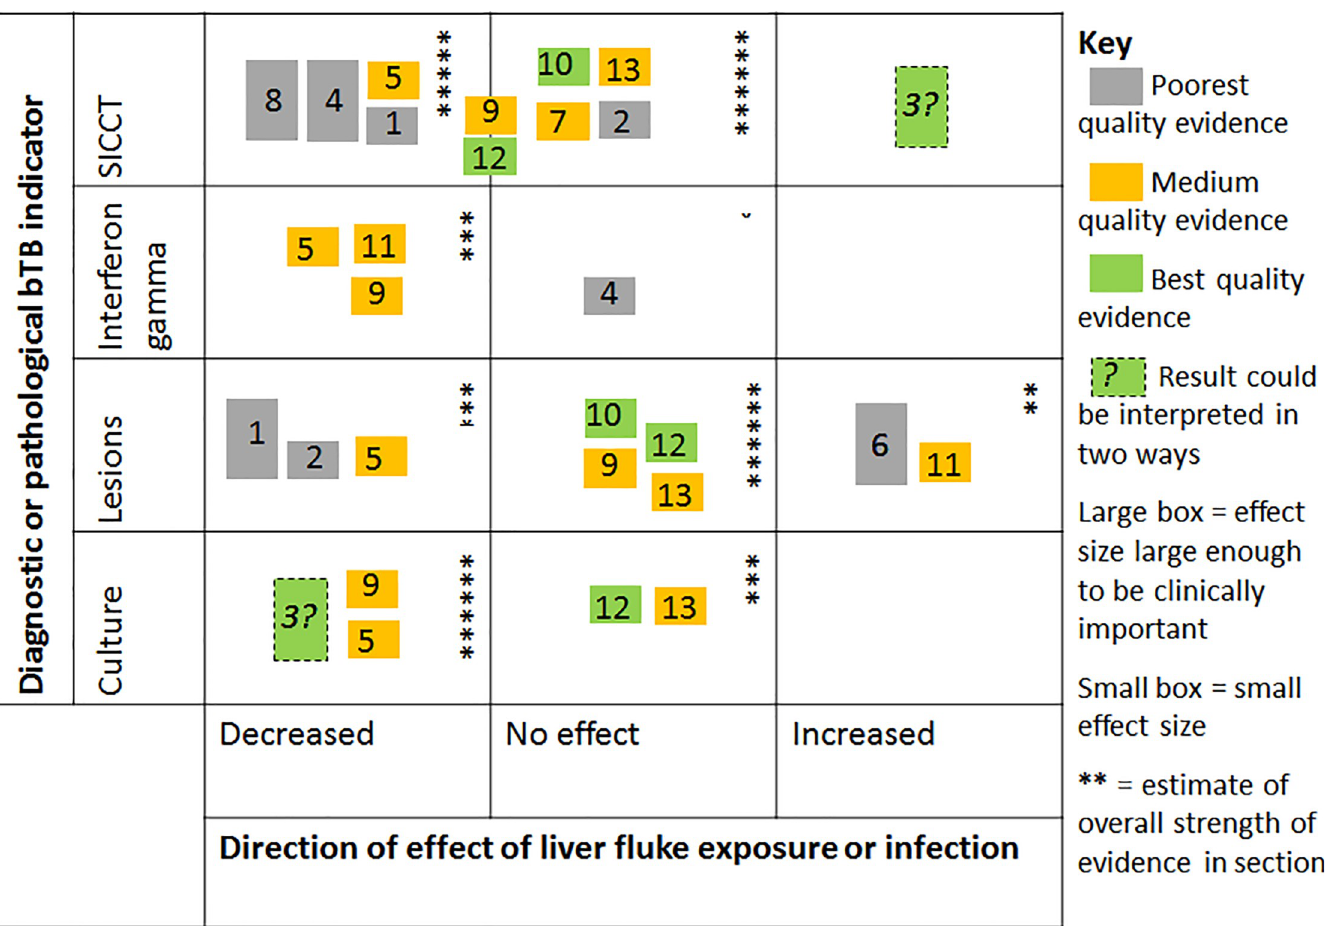
Fig 2. A harvest plot showing the results from the thirteen studies included in the analysis. The numbers correspond to study numbers given in Tables 1 and 3. Studies which cover more than one aspect are included more than once. Quality of evidence relates to the likelihood of bias and the clarity of reporting. The size of the box is an assessment of the likely clinical importance of the finding, if it were true. Small effect boxes include some results considered statistically significant. The number of stars was decided by allocating a value of 2 for best quality evidence, 1 for medium and 0.5 for poorest quality evidence, and multiplying this by 1 for a small box and 2 for a large box, then summing all the values within that section. Studies are shown on the border line if there was a difference in skin test reaction size but this did not affect binary skin test